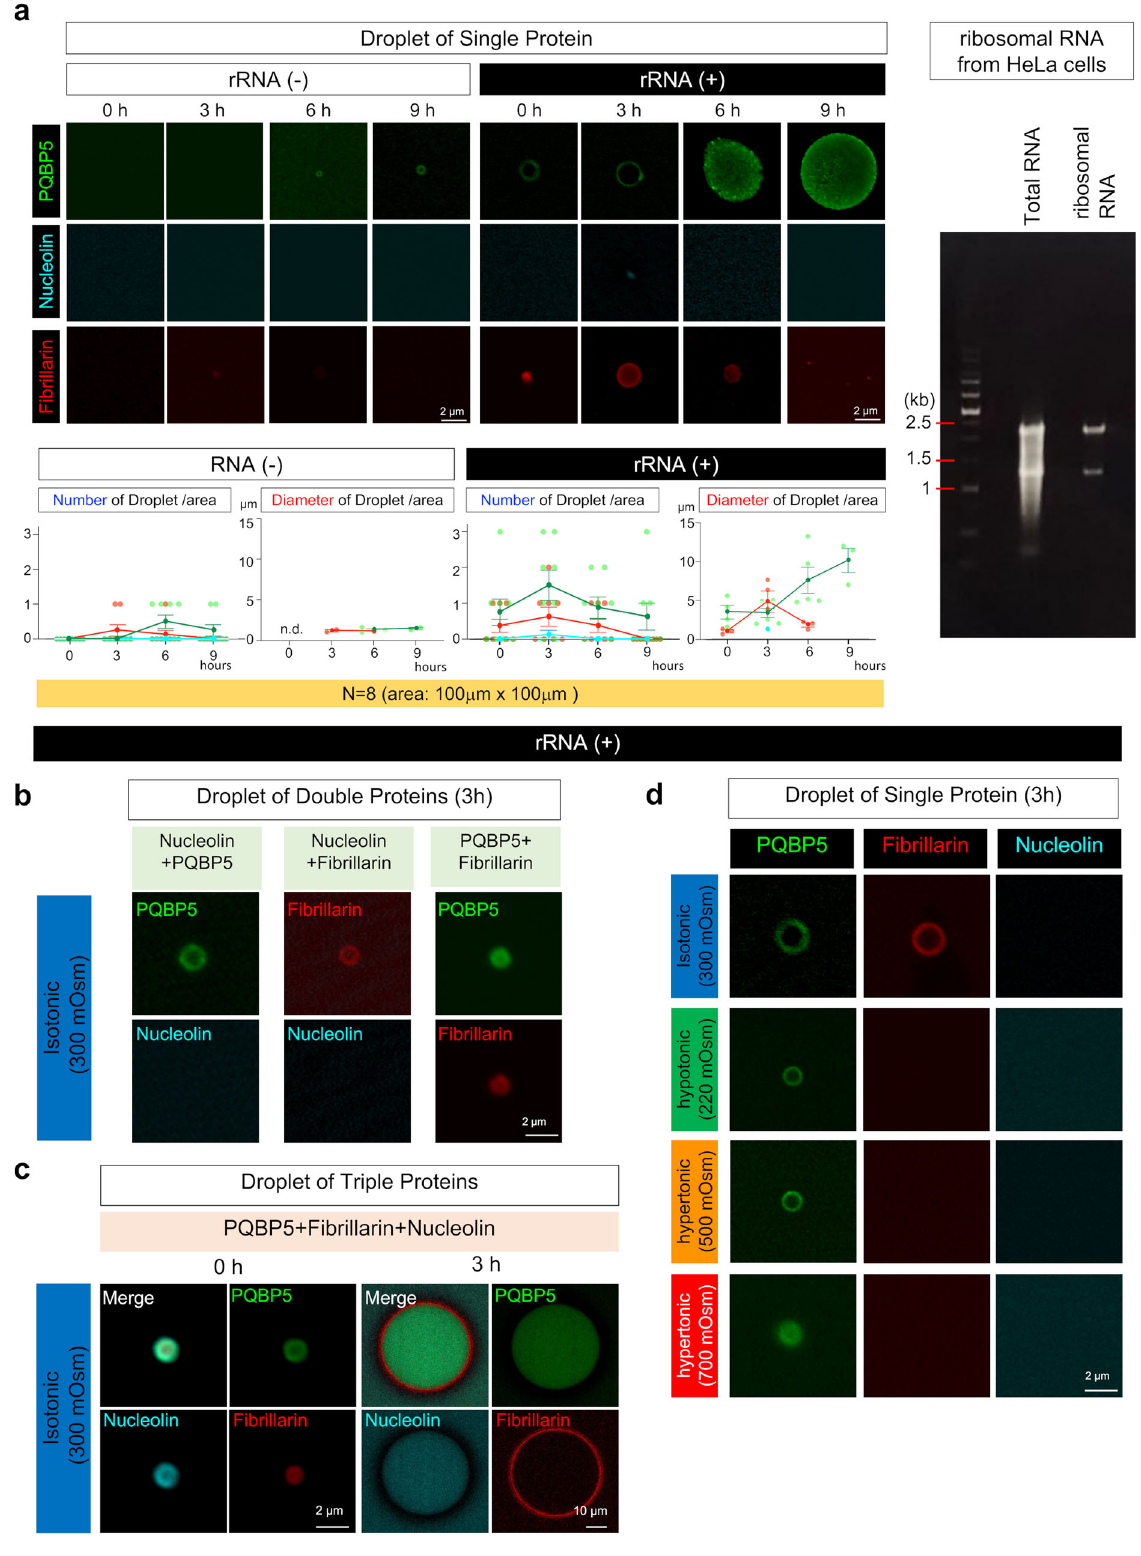
nucleolin was immediately labeled with thermal shift dye at 25°C, whereas fi brillarin was less labeled and PQBP5 was hardly labeled (Fig. 5a, left panels). The protein structures predicted by AlfaFold (https://alphafold.ebi.ac.uk/) indicated that the total length of degen- erated regions was longest in nucleolin, moderate in fi brillarin,